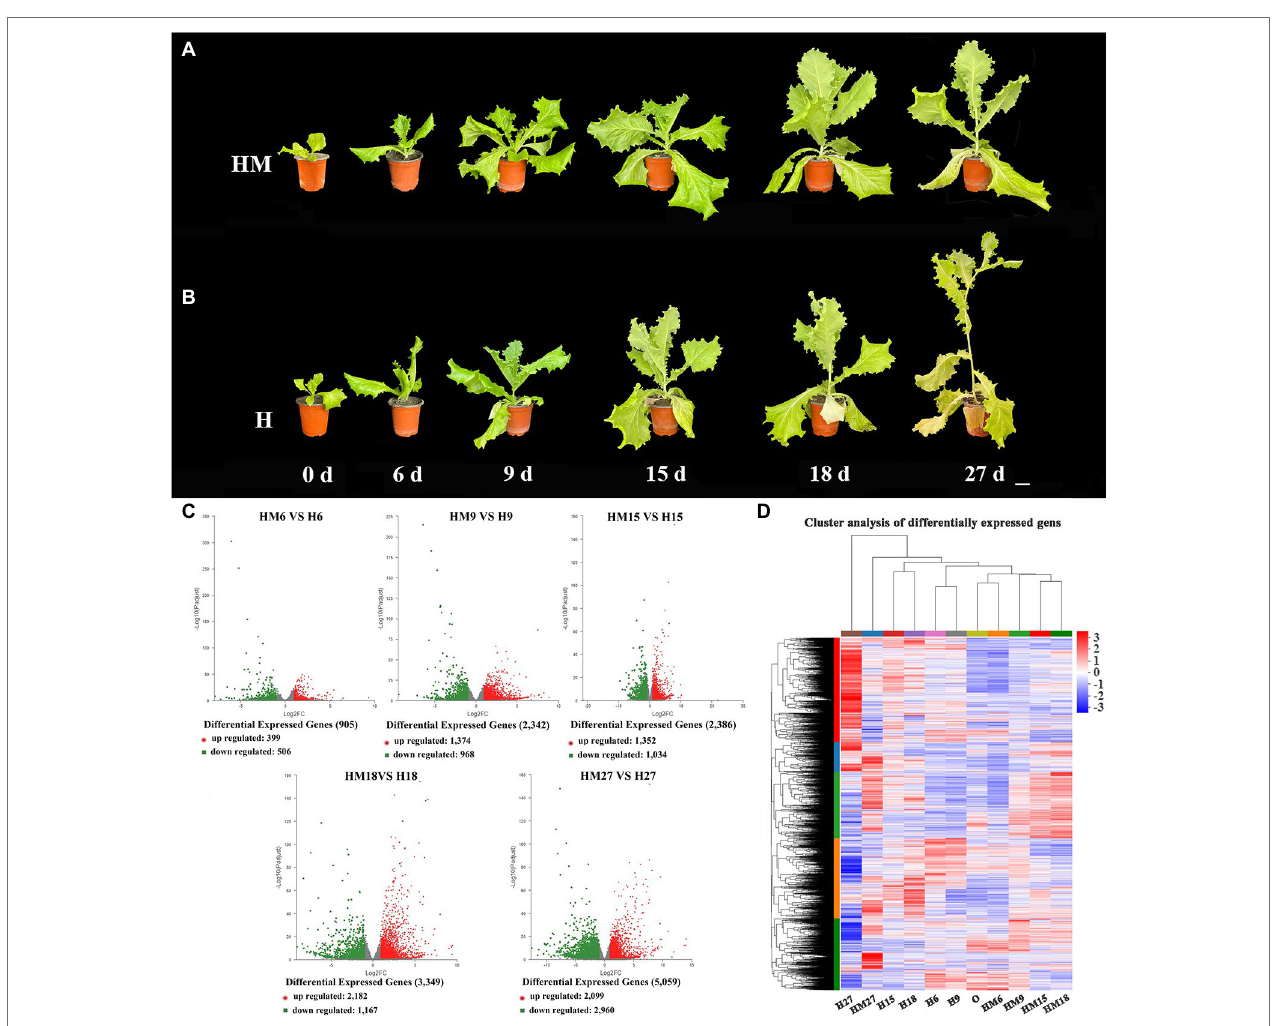
FIGURE 2 | RNA-seq analysis of leaf lettuce treated with 100 μ mol L − 1 melatonin at high temperature during the growth period (the control group did not receive exogenous melatonin under the same conditions). (A) In 100 μ mol L − 1 melatonin treatment (HM), the leaf developmental stages of phenotypes changed significantly at 0, 6, 9, 15, 18, and 27 days with different stem lengths, and whole plants were characterized. Scale bars = 5 cm. (B) In the control group that did not have exogenous melatonin (H), the leaf developmental stages of phenotypes changed significantly on 0, 6, 9, 15, 18, and 27 days with different stem lengths, and whole plants were characterized. Scale bars = 5 cm. (C) Volcano plot visualizing differentially expressed genes (DEGs). The DEGs are shown in red and green. The x -axis represents the fold change in HM6 vs. H6, HM96 vs. H9, HM15 vs. H15, HM18 vs. H18 and HM27 vs. H27 (on a log2 scale), and the y -axis represents the negative log10-transformed p values ( p < 0.05) of the t test for determining differences between the samples. (D) Cluster analysis of DEGs during different leaf